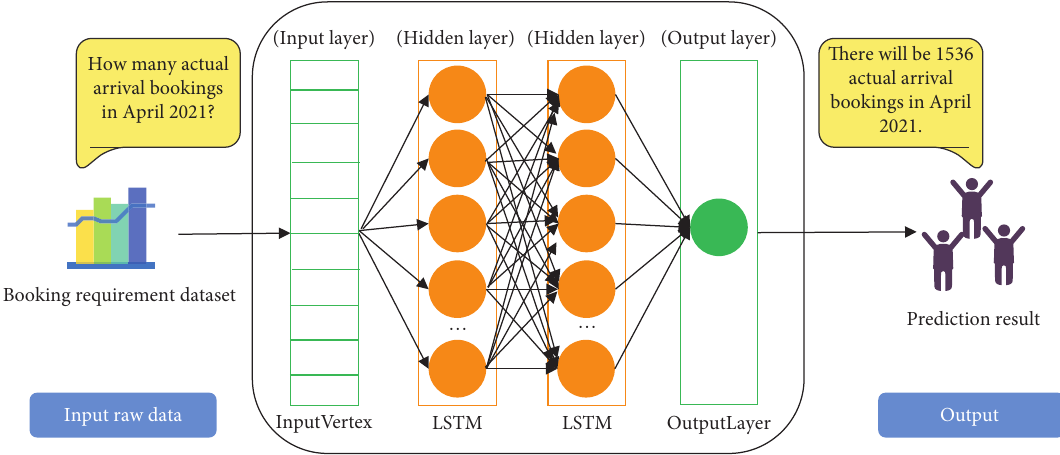
Figure 3: Prediction model